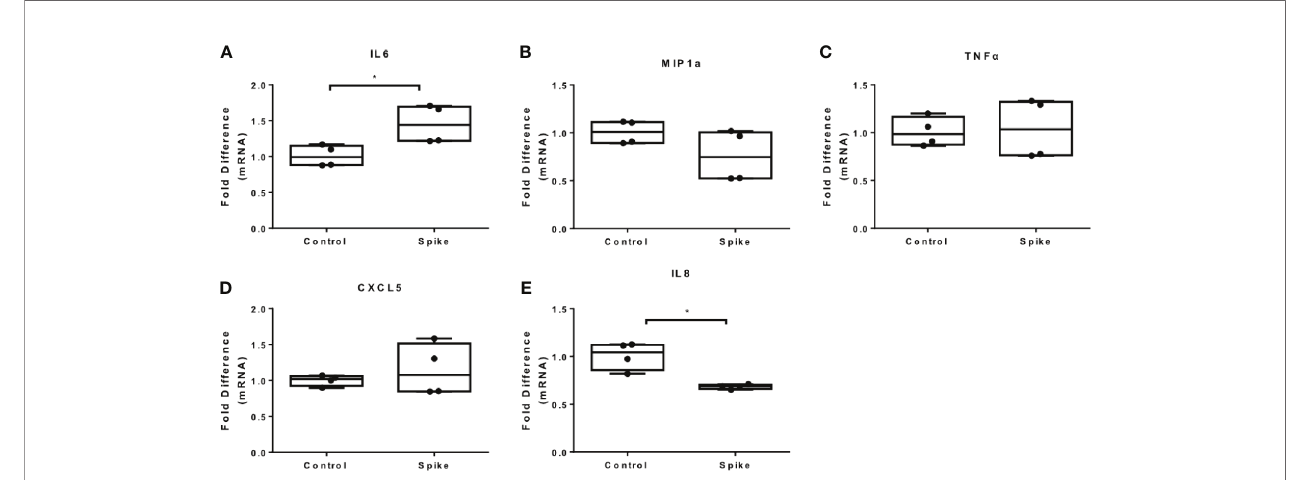
FIGURE 3 | SARS-CoV-2 S protein increased IL6 expression in PAM3csk4-induced THP-1 macrophages. THP-1 macrophages were treated with 20ng/ml SARS- CoV-2 S protein and PAM3csk4 for 12 hours. (A) PAM3csk4-induced IL6 expression increased in the presence of SARS-CoV-2 S protein, (B – D) No effect observed for MIP1a, TNF a and CXCL5 expression, (E) PAM3csk4-induced IL8 expression decreased. Data are illustrated in box-and-whiskers and plotted as median (± min, max). Statistical analysis was performed with Mann – Whitney U test. *p < 0.05.